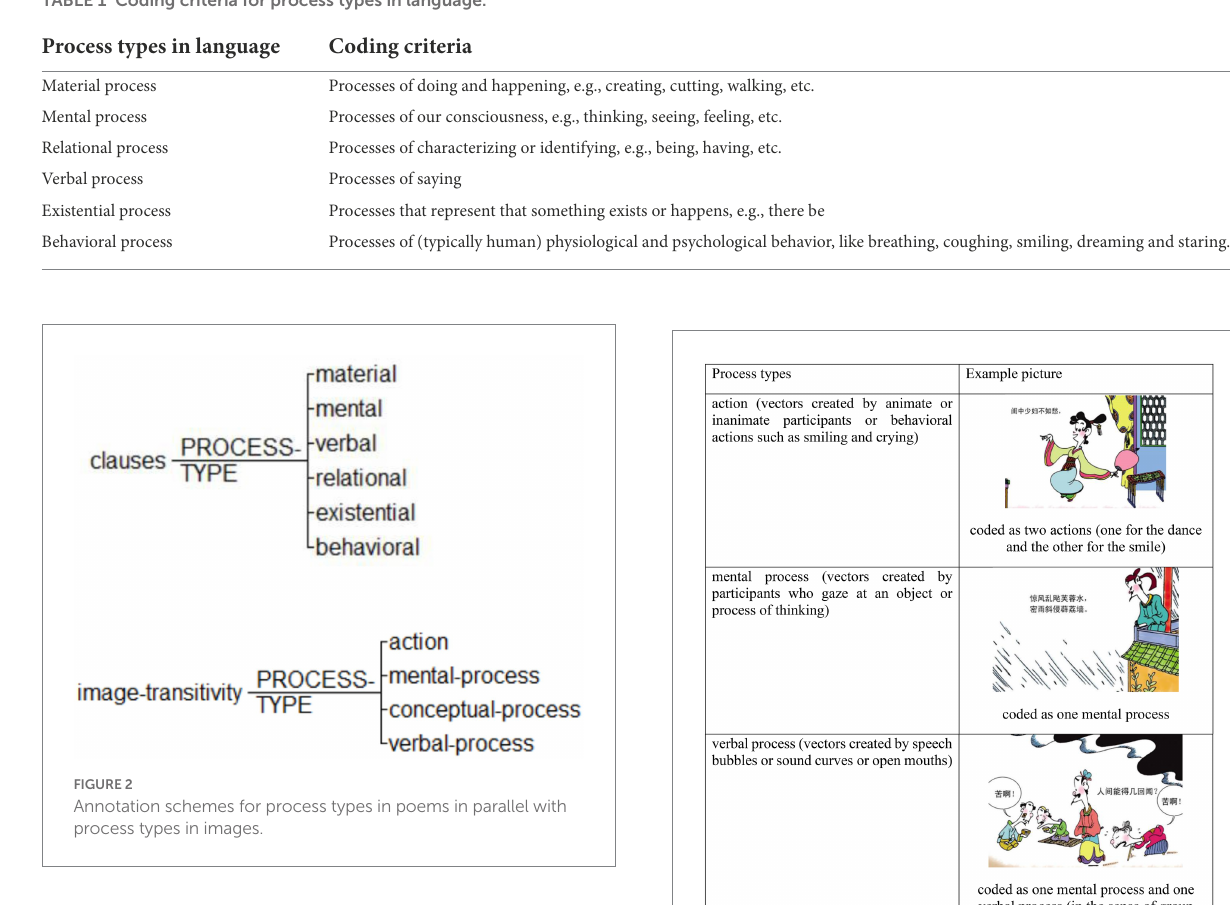
TABLE 1 Coding criteria for process types in language.